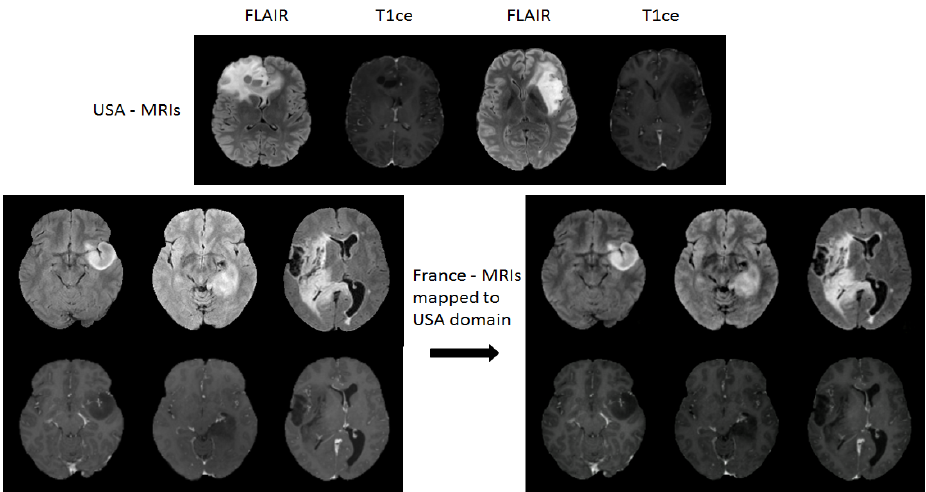
Figure 7. Visual inspection of image slices before and after the domain mappings. Top: Examples of FLAIR-MRIs and T1ce-MRIs from USA dataset. Bottom left: 3 original 2D slices of FLAIR-MRIs (1st row) and T1ce-MRIs (2nd row) from France dataset. Bottom right: Domain mapped 2D slices of FLAIR-MRIs (1st row) and slices from T1ce-MRIs (2nd row) from France to USA